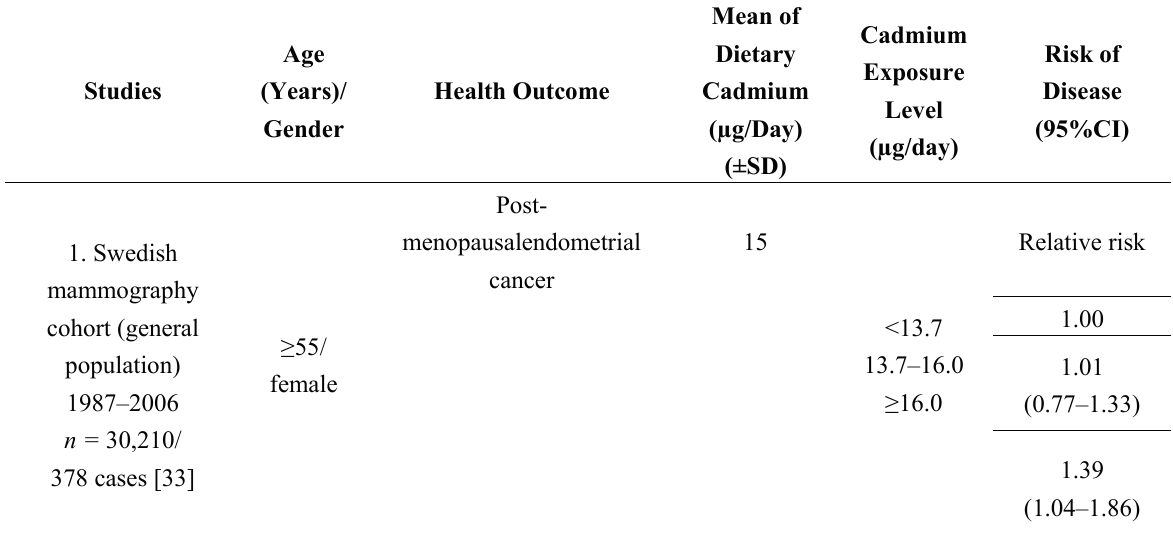
Table 3. Selected studies with dietary cadmium level and risk of health outcome for PAF estimation in Mae Sot